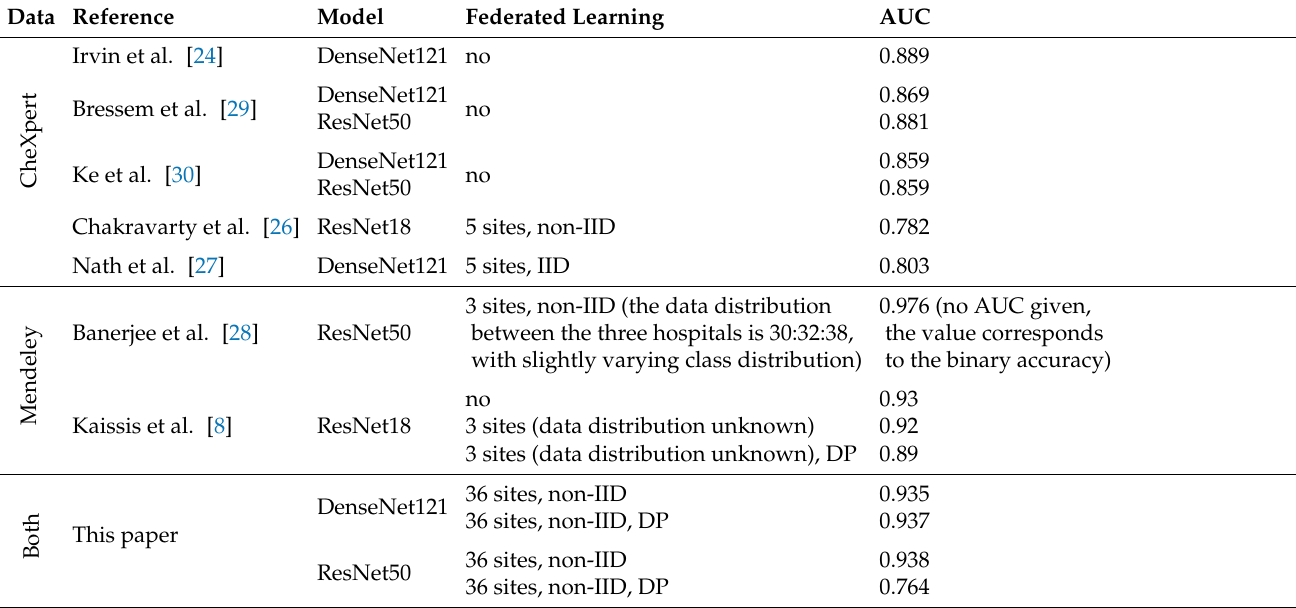
Table 1. Overview of related works evaluating deep neural networks on the CheXpert or Mendeley datasets using DenseNet or ResNet architectures. The mentioned models are not necessarily exhaus- tive; some papers evaluate additional ResNet and DenseNet architectures. We also include our paper at the bottom for comparison with related work. Note: (non-)IID corresponds to a (not) independent and identical data distribution. DP corresponds to the use of differential privacy ( ε =